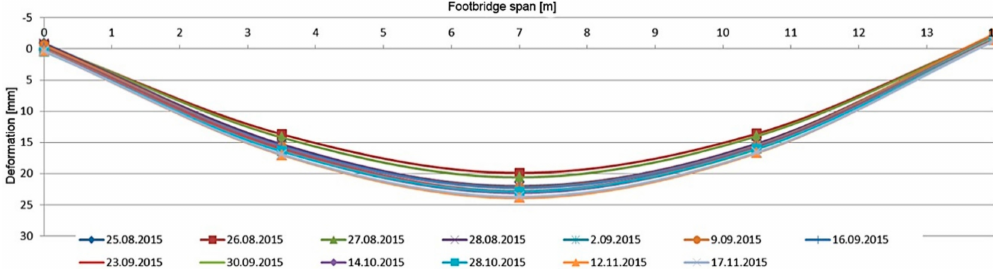
Figure 21. Displacements in U4 measurement points, footbridge with ballast.